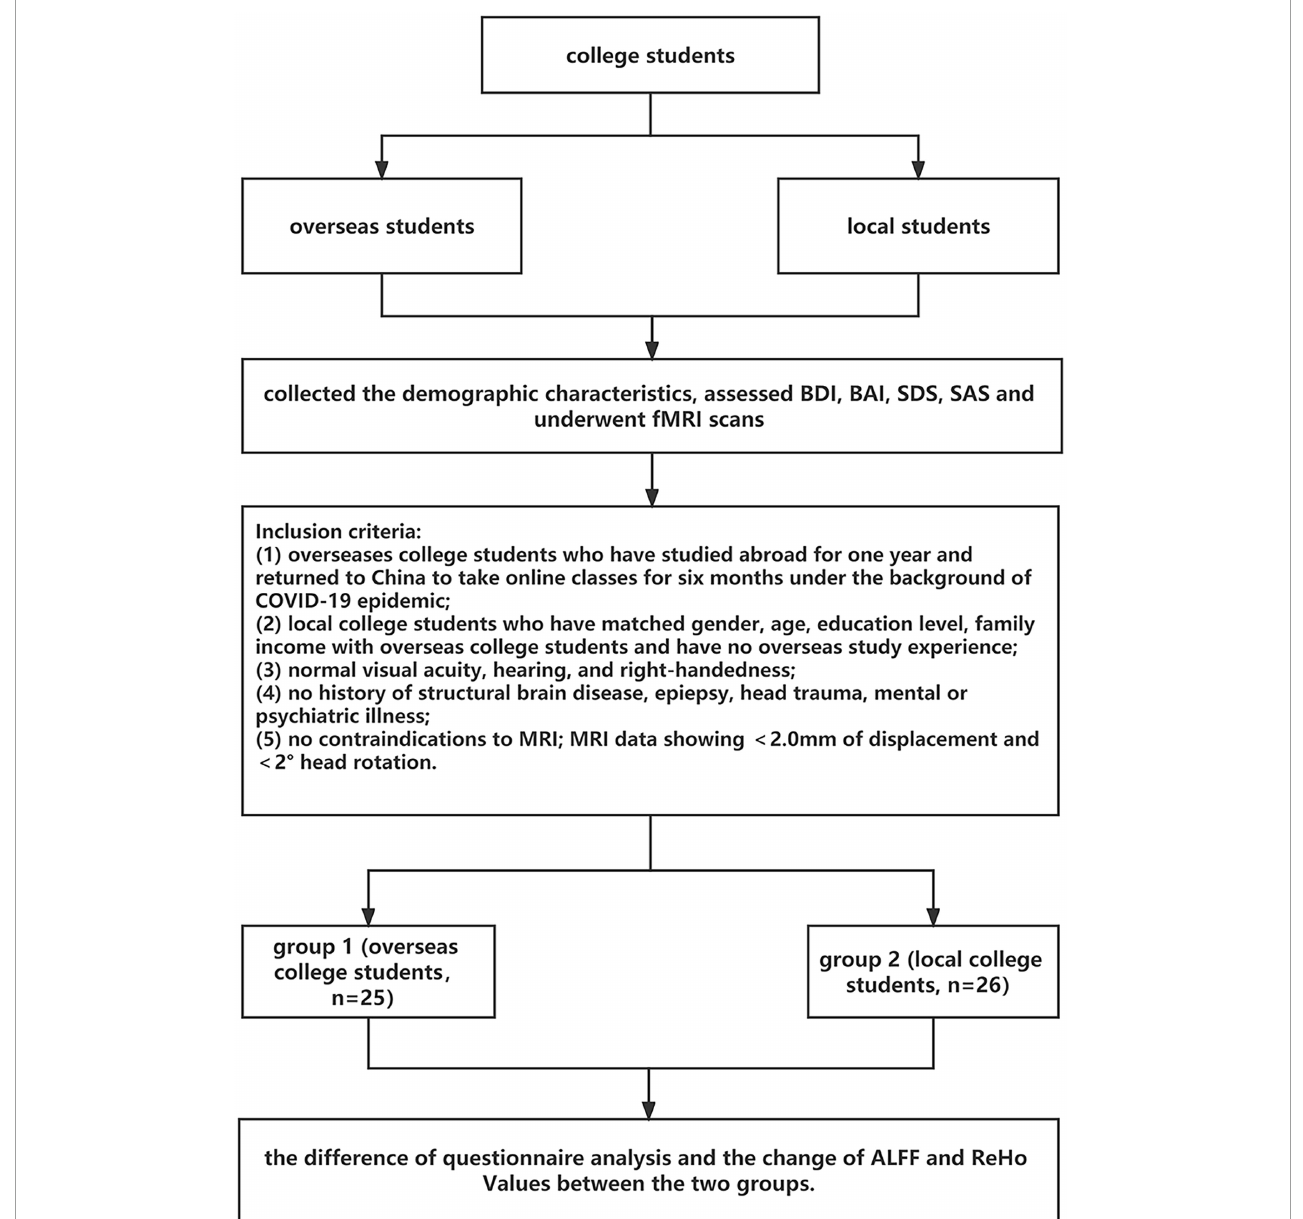
FIGURE1 Flowchart of participant recruitment and data